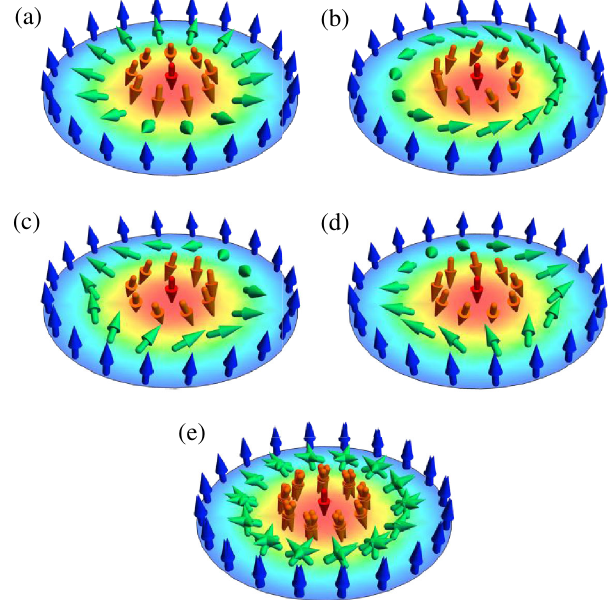
FIG. 1. Schematic plot of the classical spin configurations of skyrmions and antiskyrmions. In panels (a) and (b) skyrmions with helicity ϕ ¼ 0 and ϕ ¼ π = 2 are shown. In panels (c) and (d) the corresponding antiskyrmions are displayed. Skyrmions are rotationally symmetric as the spin rotates with the spatial coordinate. For antiskyrmions the direction of spatial and spin rotations is opposite; see Eq. (2). A quantum skyrmion in a frustrated magnet can tunnel between skyrmion and antiskyrmion states and is approximately described by superpositions of classical configurations, as shown in